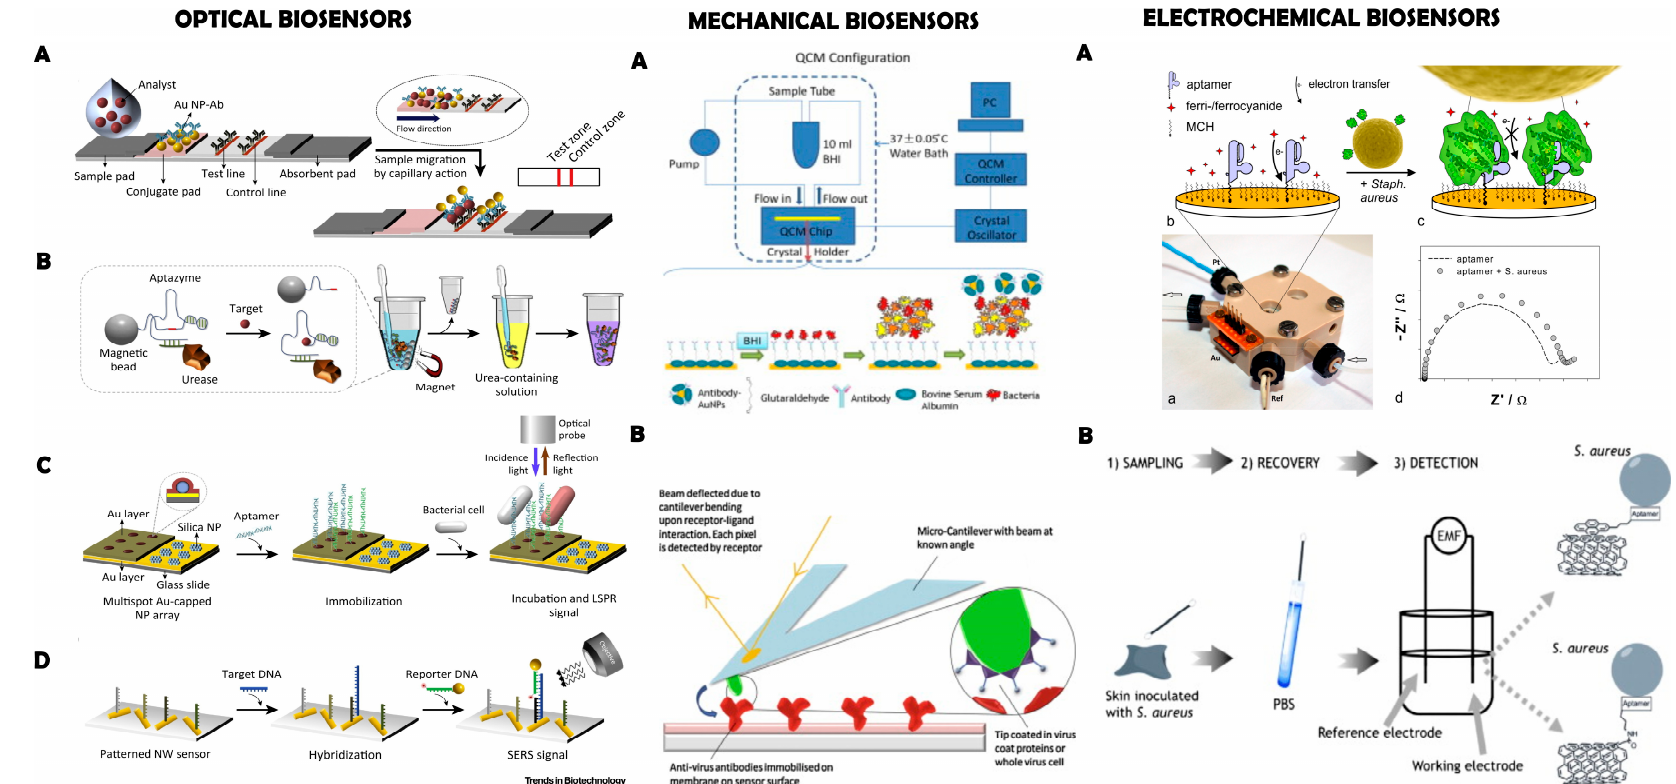
Figure 3. Three types of biosensors. OPTICAL BIOSENSORS: ( A ) lateral flow assay (LFA)-based biosensor; ( B ) solution-based colorimetric biosensor; ( C ) localized surface plasmon resonance (LSPR)-based biosensor; ( D ) surface-enhanced Raman scattering (SERS)-based biosensor. (NP: nanoparticle). Reprinted from [42], with permission from Elsevier. © 2015 Elsevier Ltd. MECHANICAL BIOSENSORS: ( A ) Nanoparticle-functionalized piezoelectric biosensor – quartz crystal microbalance (QCM) system. Reprinted from [50], with permission from Elsevier. © 2012 Elsevier B.V.; ( B ) Antibody conjugated microcantilever using atomic force microscopy (AFM) tapping mode. Reprinted from [6], with permission from Elsevier. © 2010 Elsevier B.V. ELECTROCHEMICAL BIOSENSORS: ( A ) Aptamer functionalized impedimetric biosensor. Figure reproduced from [71]; ( B ) Potentiometric biosensor. Reprinted from [70], with permission from Elsevier. © 2011 Elsevier B.V.